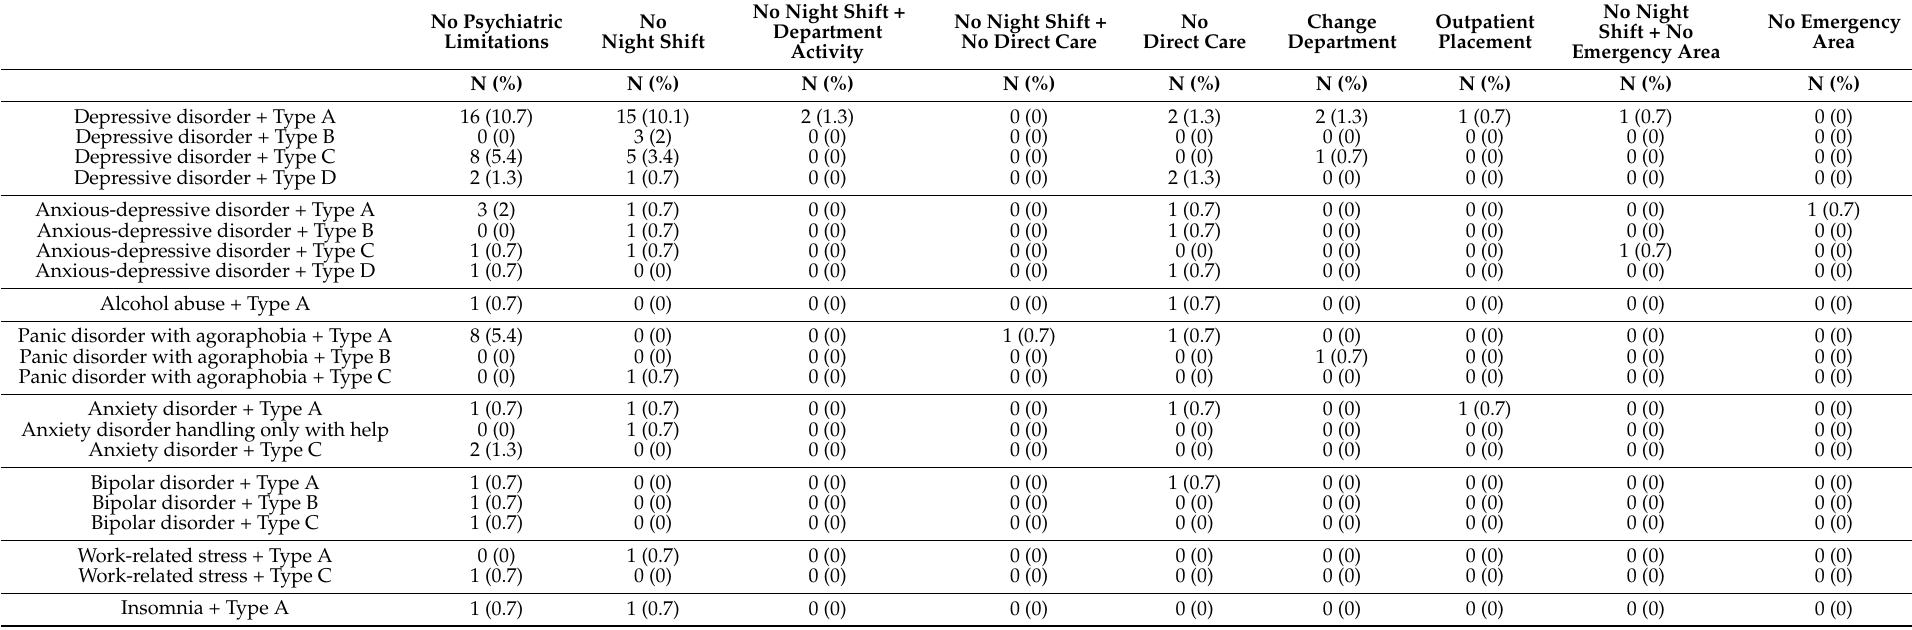
Table 4. Frequencies of participants with same psychiatric diagnosis/same orthopedic limitation, according to psychiatric limitations to